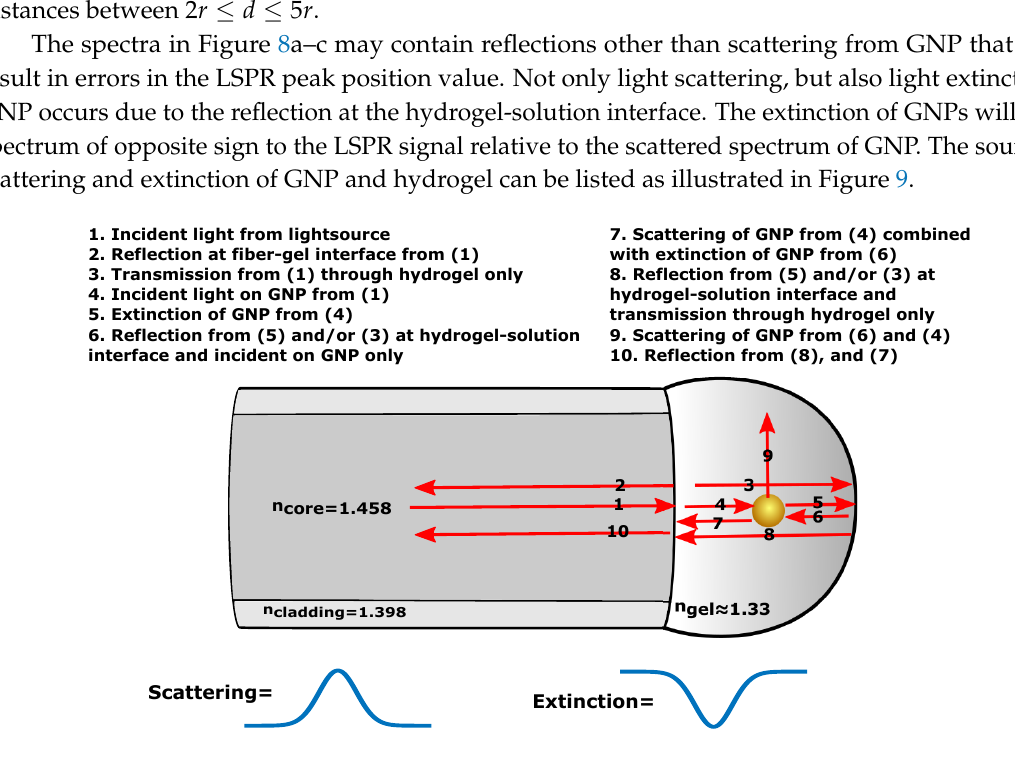
Figure 9. Sources of scattering and extinction from hydrogel and